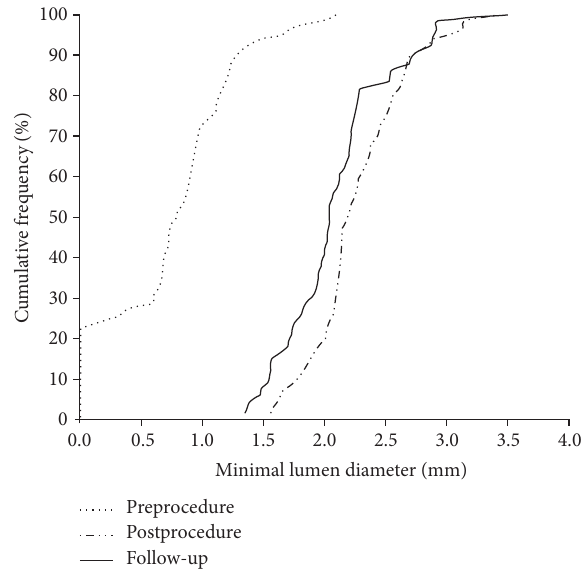
Figure 5: Cumulative frequency distribution curves of in-stent minimal lumen diameter by